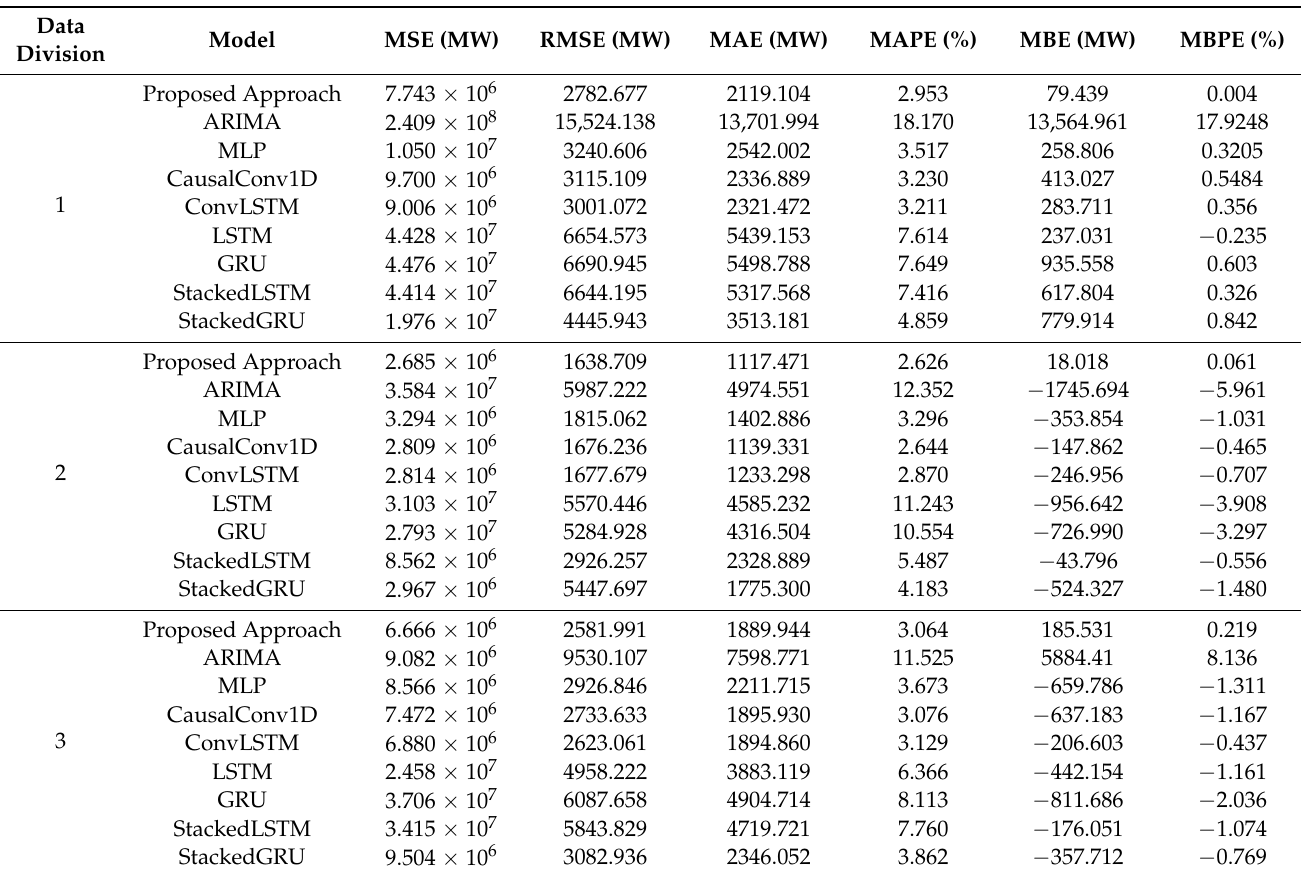
Table 3. Error metrics of the proposed models and comparison techniques for each data division in the testing set. Data